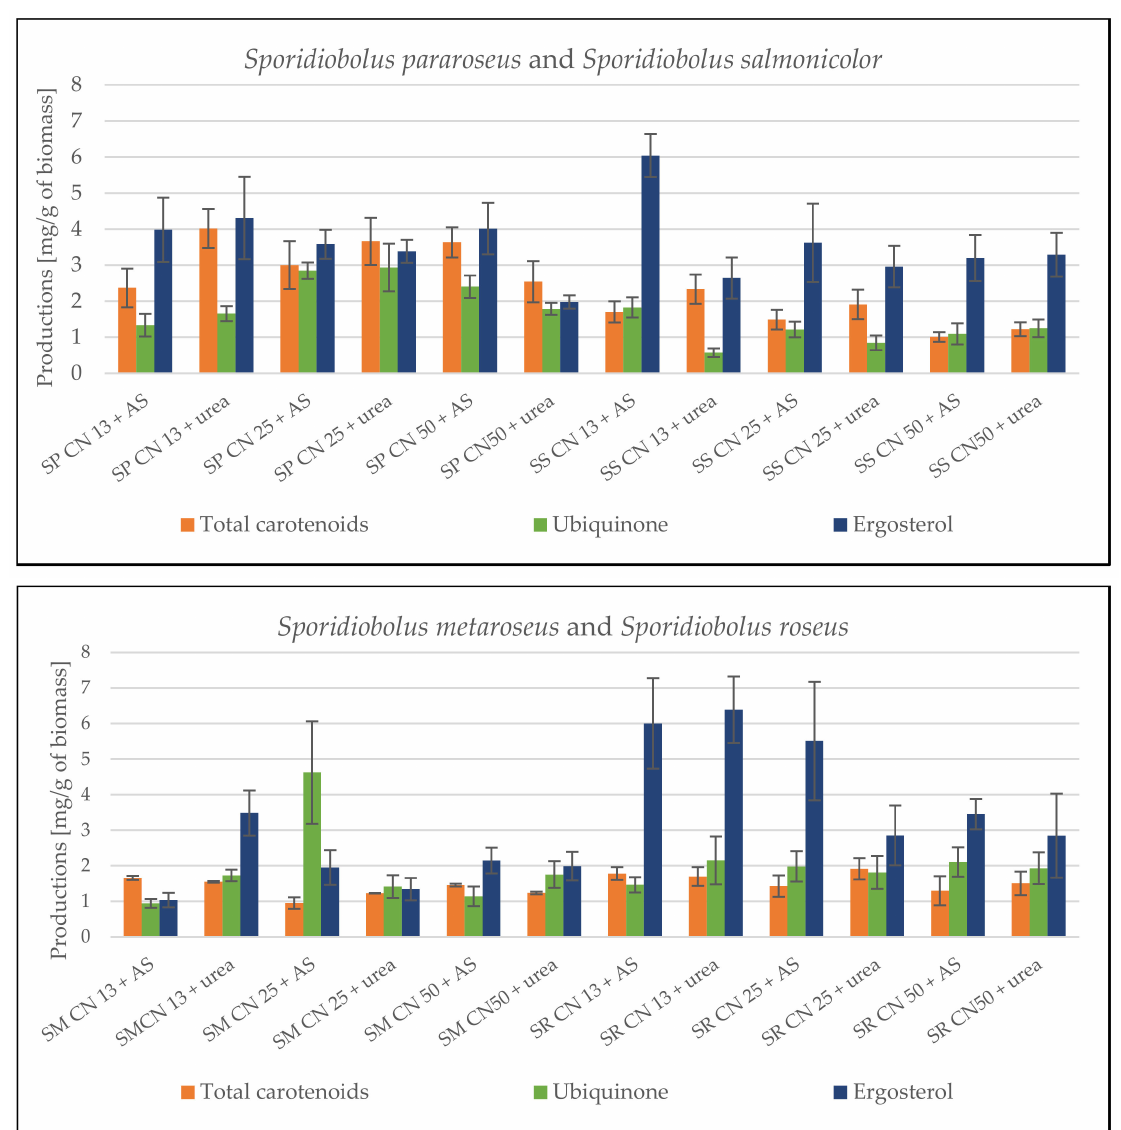
Figure 1. HPLC analysis results of total carotenoids, ergosterol and ubiquinone production in screening cultivation on SCG hydrolysate. Productions are listed in mg/g of cell dry weight. Abbreviations: SP— Sporidiobolus pararoseus; SS— Sporidiobolus salmonicolor; SM— Sporidiobolus metaroseus; SR— Sporidiobolus roseus